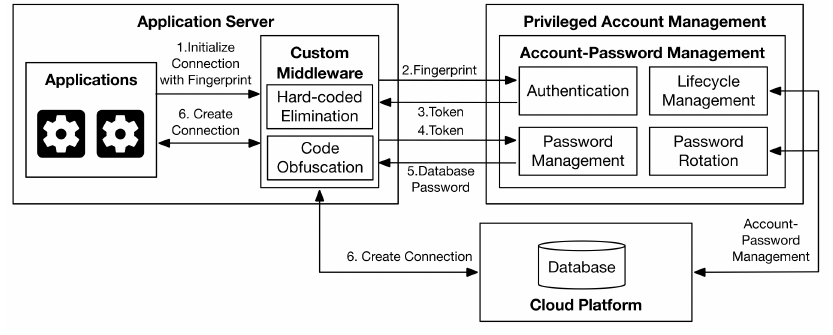
Figure 7. Application-access process of Privileged Account Management